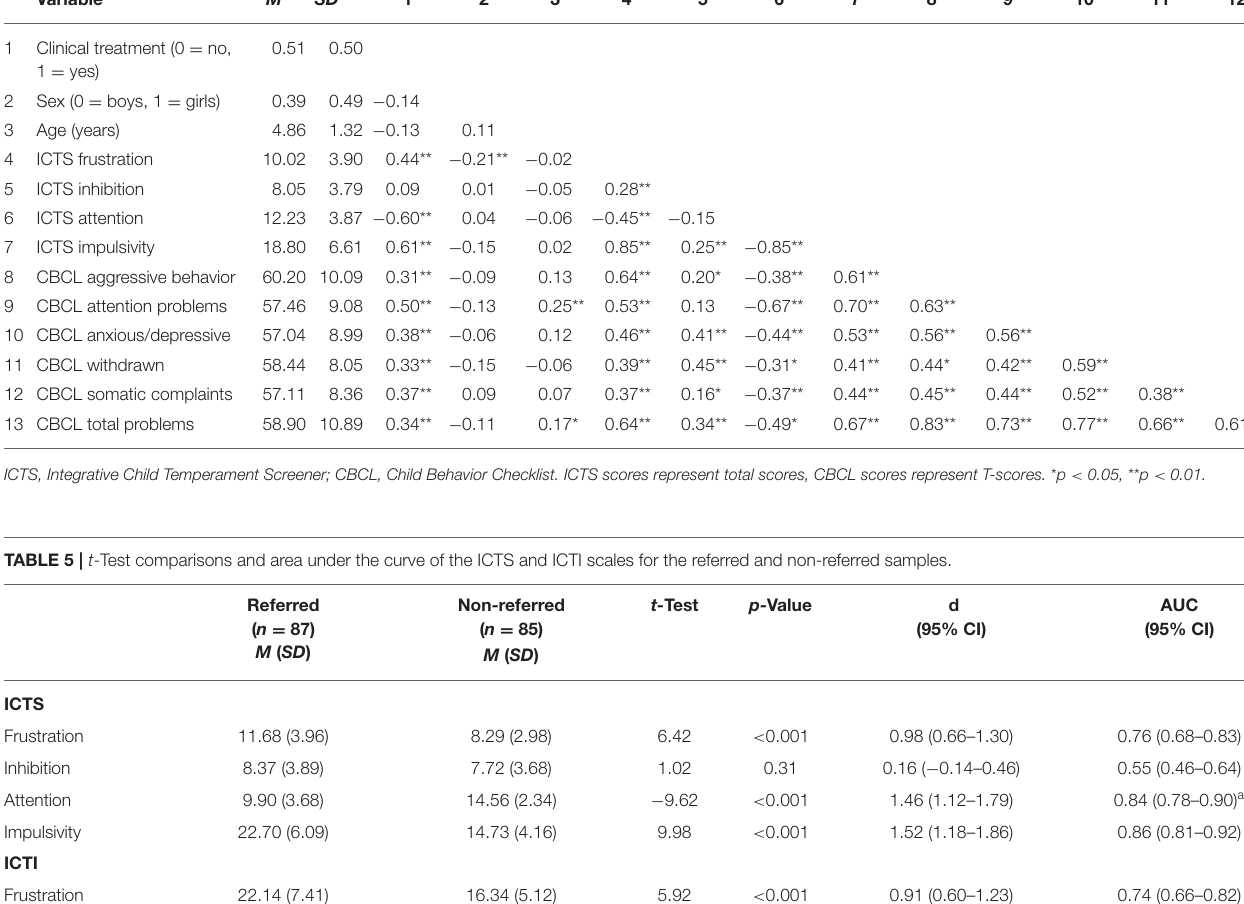
TABLE 4 | Means, standard deviations, and Pearson zero-order correlations. Variable